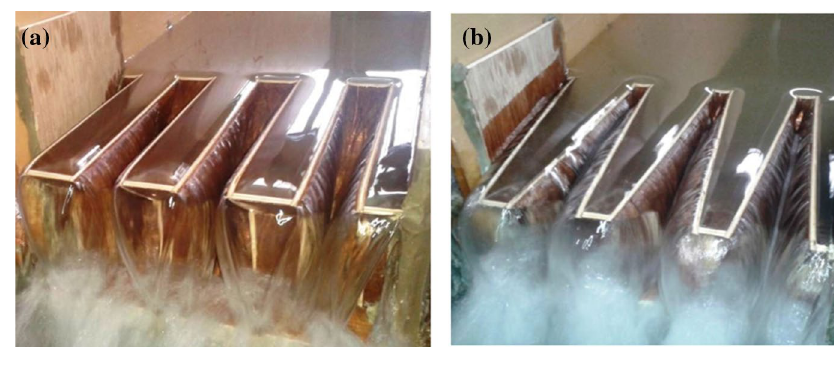
Table 1 Detail of piano key weir